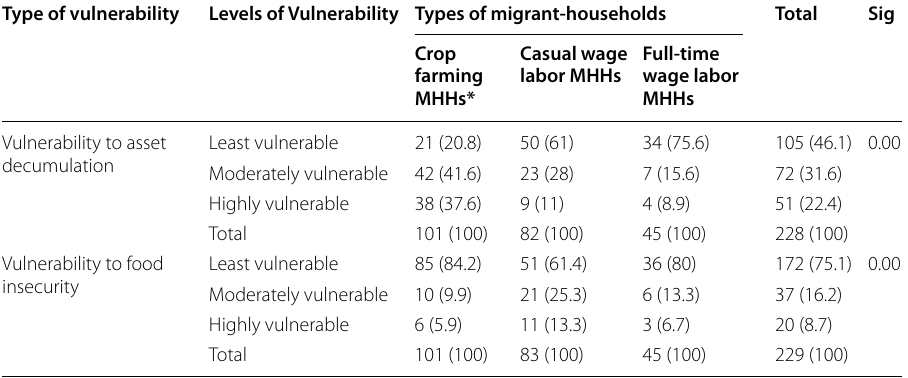
Table 7 Level of vulnerability to asset decumulation across and food insecurity across types of migrant-households. Source : Own Household Survey